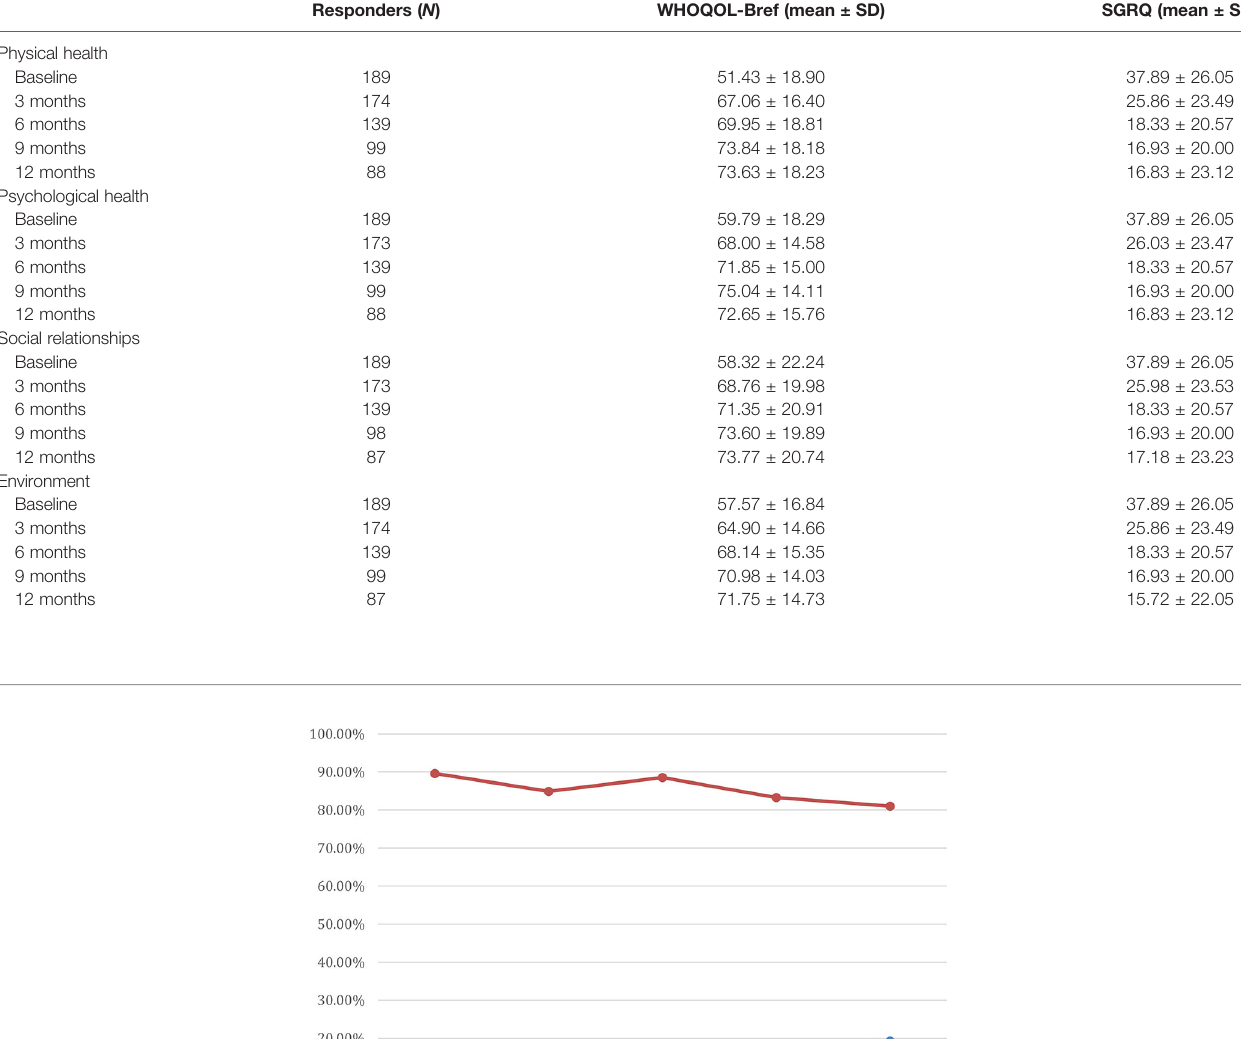
TABLE 3 | Mean scores for different domains of the